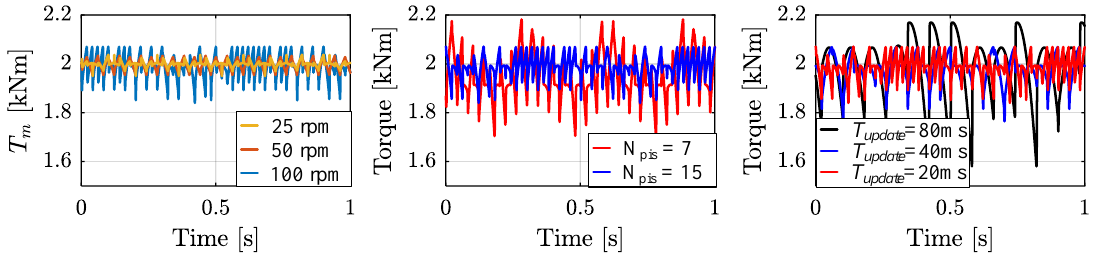
Figure 25. Steady-state response SPSDS at various shaft speeds ( left plot ), with various numbers of cylinders ( mid plot ) and various controller update frequencies ( right plot